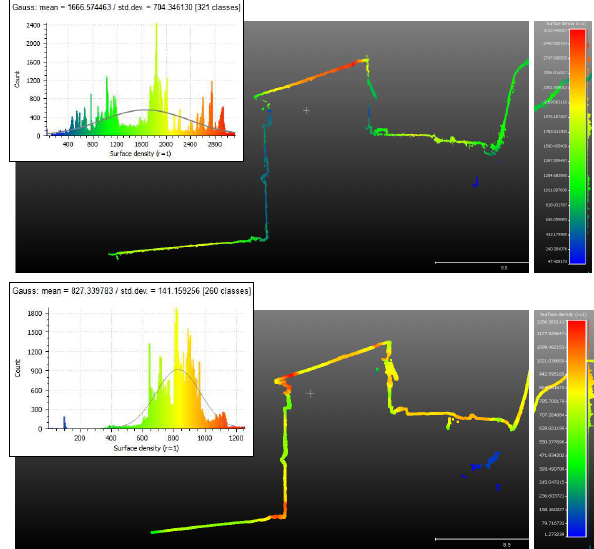
Figure 15-16. Density for aerial point cloud (top). Density for data fusion point cloud (down)